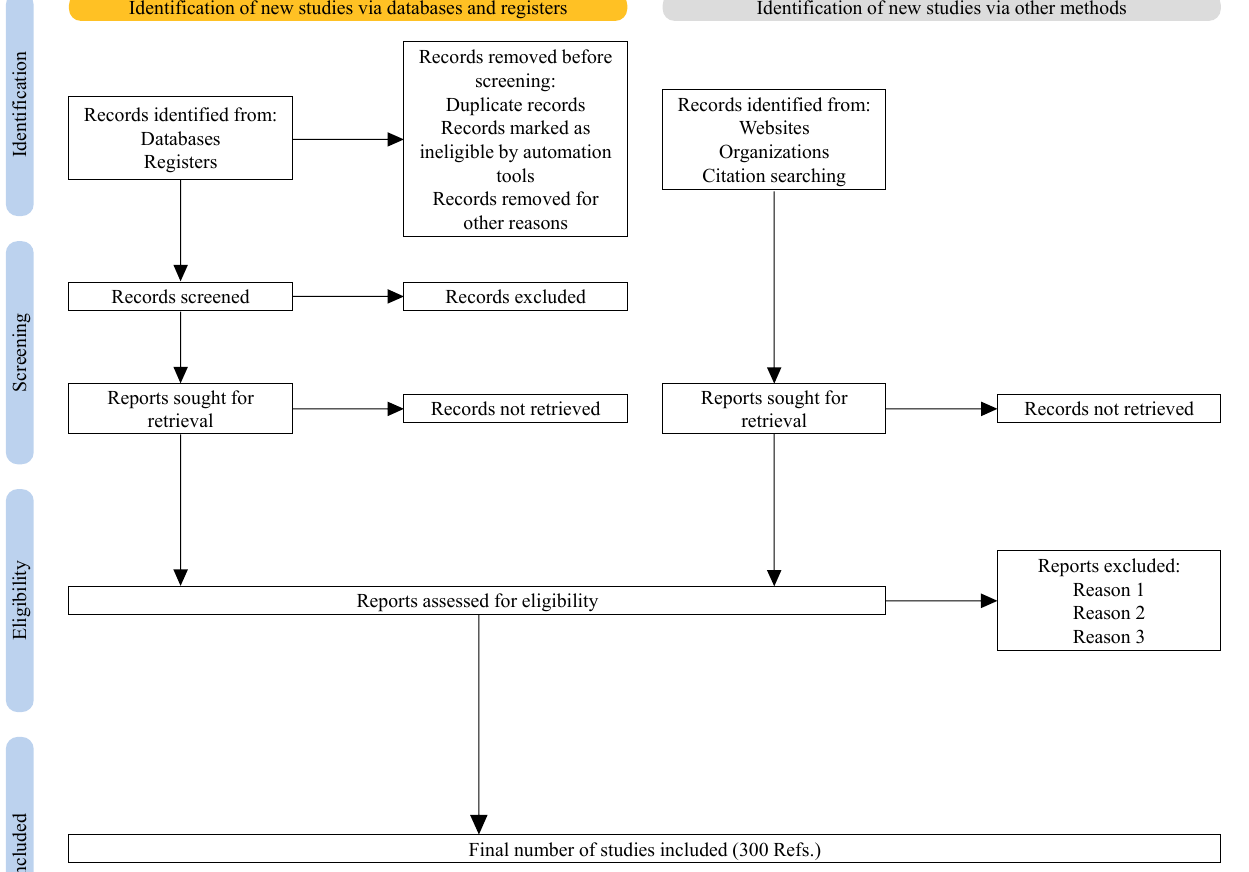
Figure 7. A schematic flowchart of PRISMA guidelines [78] used to prepare the current review.